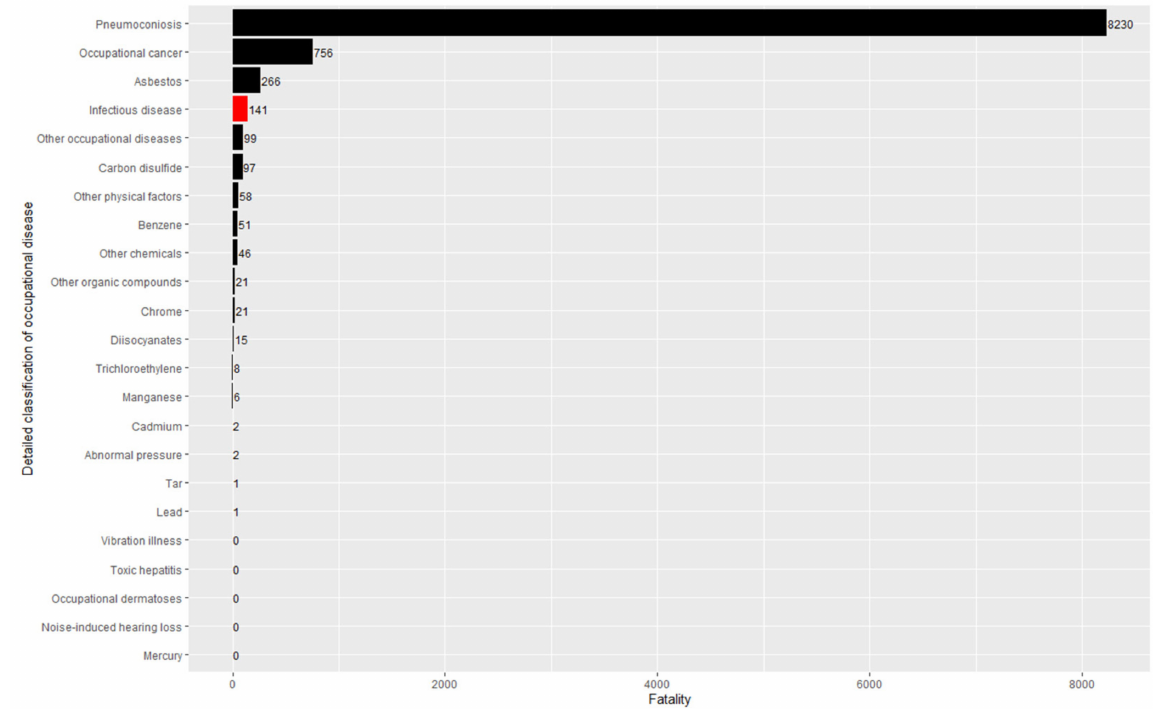
Figure 2. Fatalities of occupational diseases